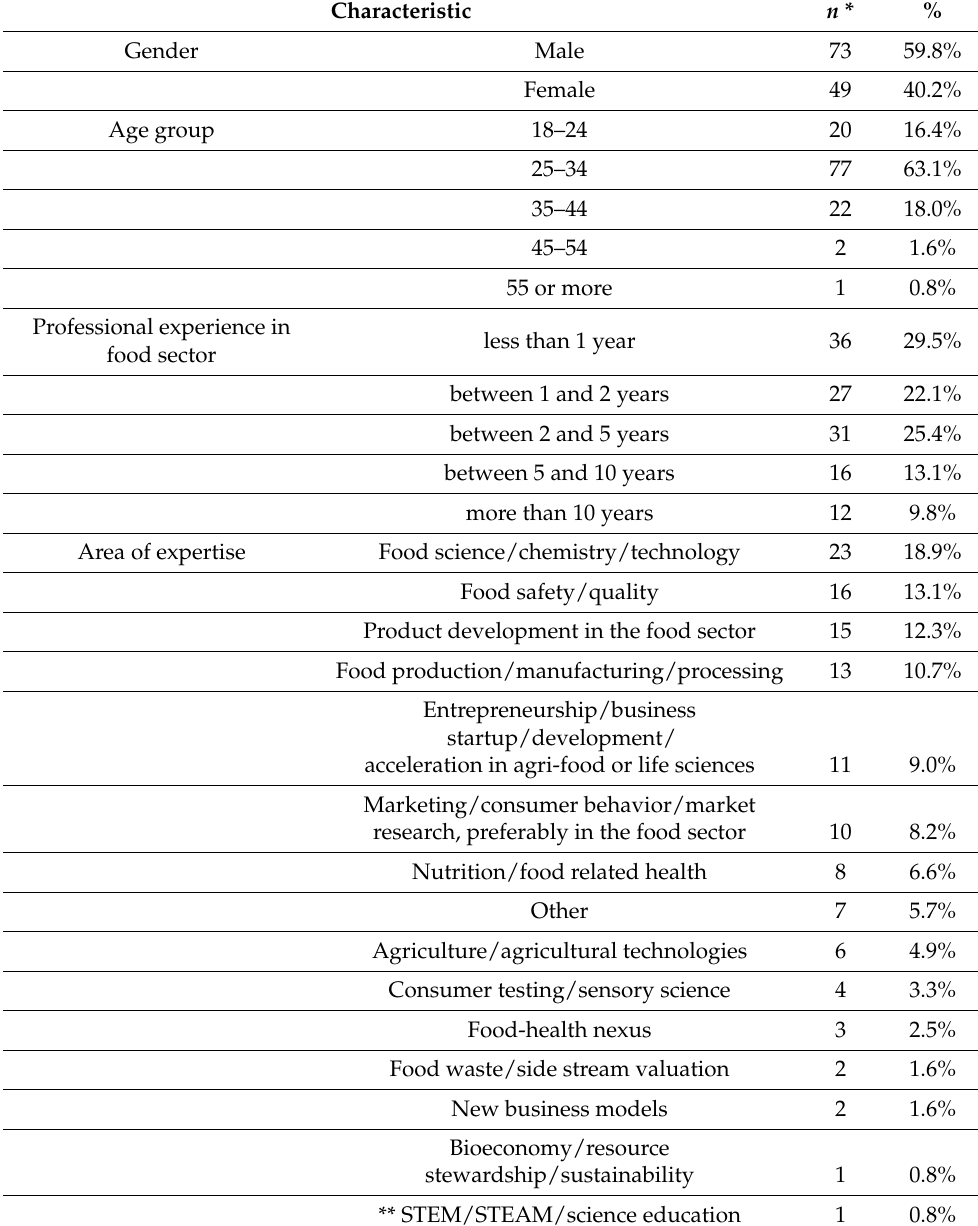
(Table 3). Respondents differ in gender, age and length of professional experience in the food sector. Table 3. The characteristics of the respondents ( n =